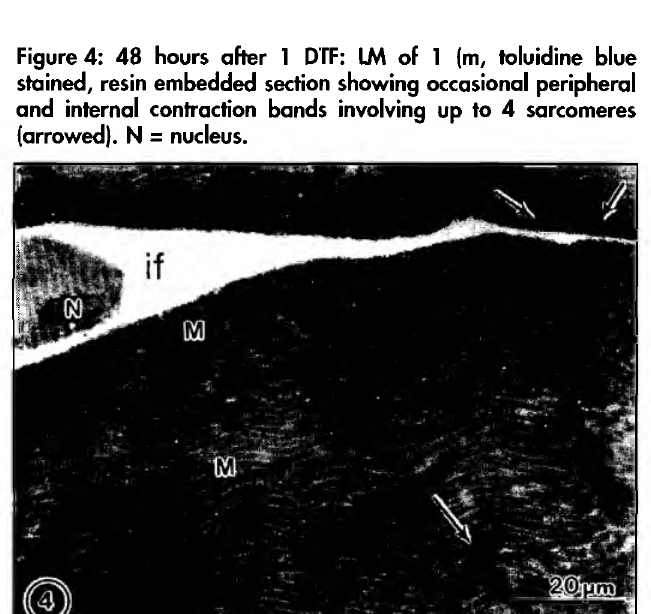
Figure 5: 6 days after 3 DTF: LM of 1 (m, toluidine blue stained, resin embedded section showing large, amorphous inclusions within the fibre (AIB and arrows). Note absence of contraction bands in these fibres.